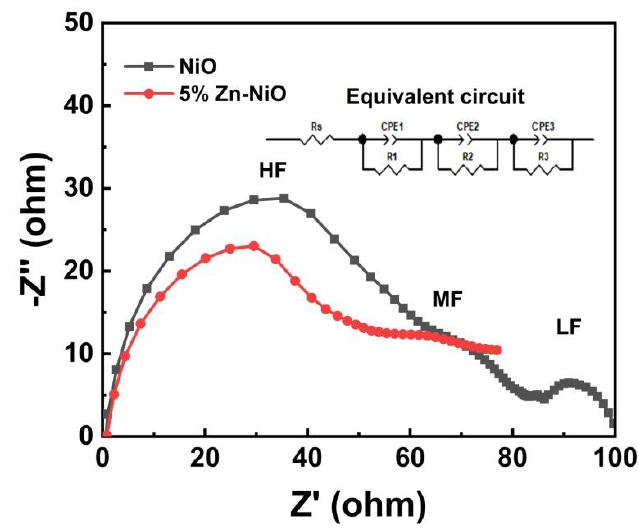
Figure 11. EIS spectra of PSCs with NiO x and 5% Zn-NiO x HTL.